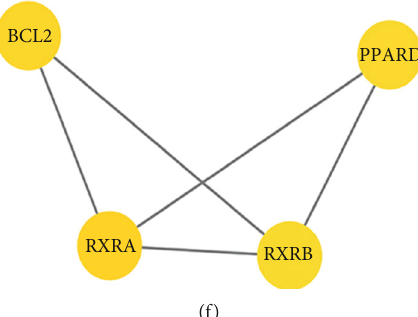
Figure 4: Compound-DKD PPI network and its clusters. (a) TwHF target-DKD target PPI network comprised of 88 nodes and 547 edges. The nodes stand for genes, and the lines stand for the interactions between a pair of target genes; The node color was redder as the degree value increased. (b – f) Clusters of compound-DKD PPI network. Five clusters were obtained in compound-DKD PPI network, and (b – f) stand for clusters 1-5. Table 2: Cluster of compound-DKD PPI network.